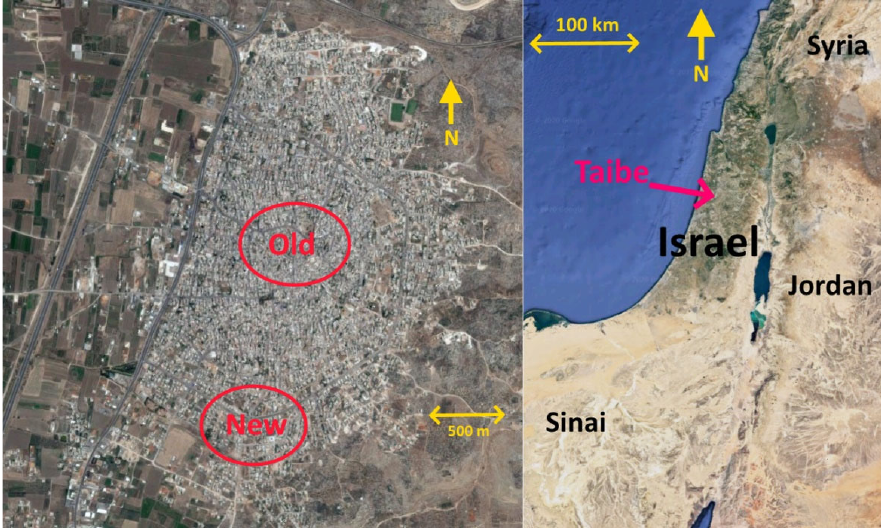
Figure 1. Map of the study site (from Google maps, Imagery ©2022 TerraMetrics, Map data ©2022 Mapa GISrael).